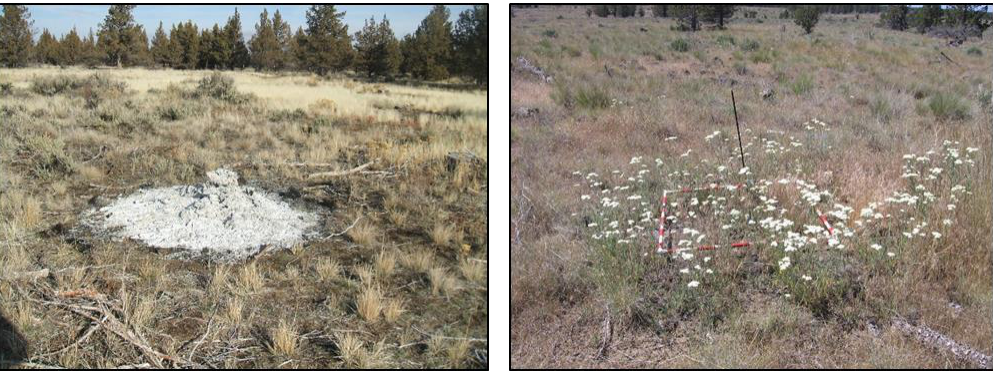
Figure 2. Slash piles after burning ( left ) and after seeding and several years of recovery ( right ).The white flowered plant on the right is common yarrow (ACMI), one of three seeded species, and the reddish grass is cheatgrass, the most common exotic annual grass in the study area. A one-meter sampling quadrat is shown on the